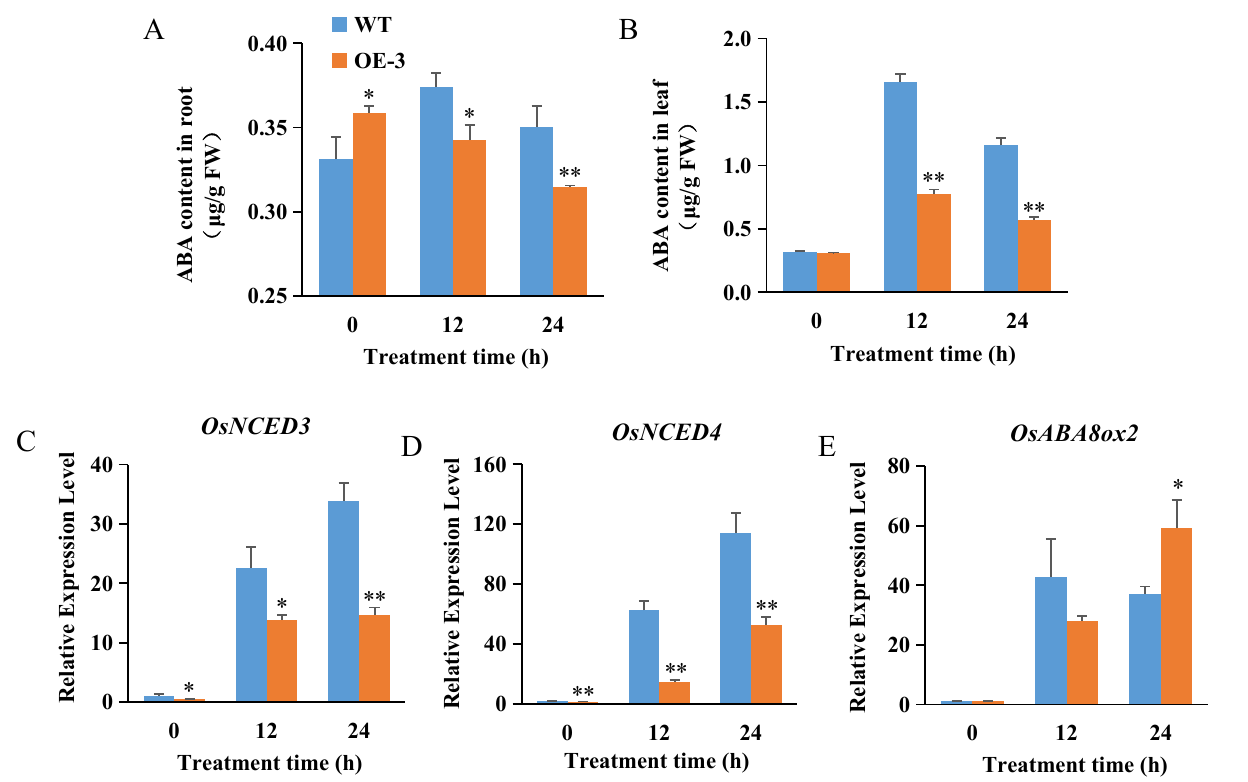
Figure 4. Overexpression of OsABT inhibits ABA synthesis under salt stress. ( A , B ) Root and leaf ABA content of the two − week − old OsABT − OE line (OE − 3) and WT plants exposed to salt stress (200 mM NaCl) for 0, 12, and 24 h. ( C − E ) Root expression of the ABA synthesis genes OsNCED3 and OsNCED4 , and the ABA catabolic gene OsABA8ox2 in the two − week − old OsABT − OE line (OE − 3) and WT plants. Root RNA was isolated and used for qRT–PCR. Actin was used as an internal control. The relative expression levels were represented by fold change relative to the expression in WT plants before salt treatment (0 h). Data are means ± SD of three independent experiments. Asterisks indicate significant differences compared to WT at * p < 0.05 and ** p < 0.01 (Student’s t − test).